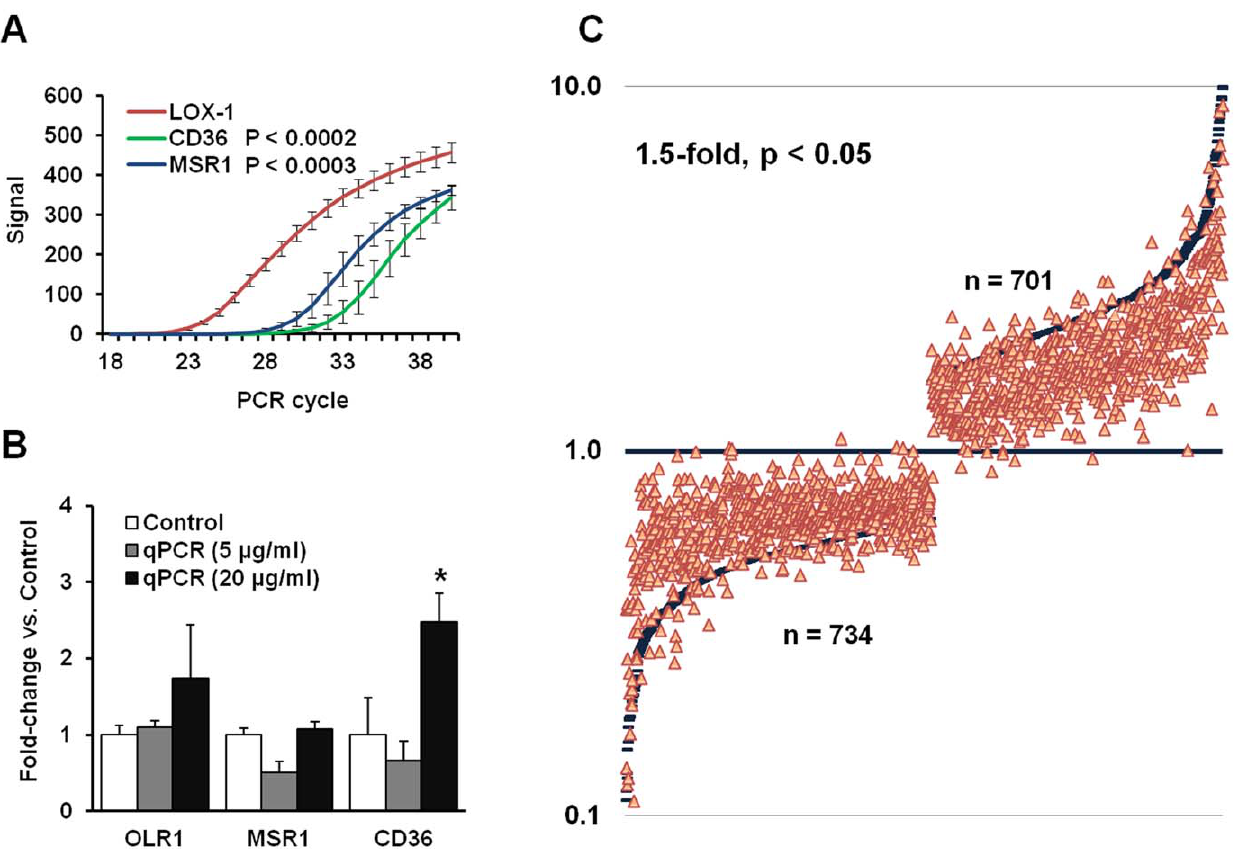
Figure 1. Ox-LDL transcriptome and its dependence on LOX-1 in endothelial cells. ( A ) – basal expression of scavenger receptors in HCAECs evaluated by qPCR. ( B ) – ox-LDL induced expression of scavenger receptors in HCAECs by qPCR. ( C ) - Differentially expressed genes (1.5-fold, p , 0.05) in HCAECs exposed to 5 m g/ml ox-LDL for 12 hrs. Blue lines represent genes up- or down-regulated more than 2-fold. Red triangles represent expression of these genes in cultures pre-treated with LOX-1 neutralizing antibody (TS92, 10 mg/ml) before ox-LDL exposure.